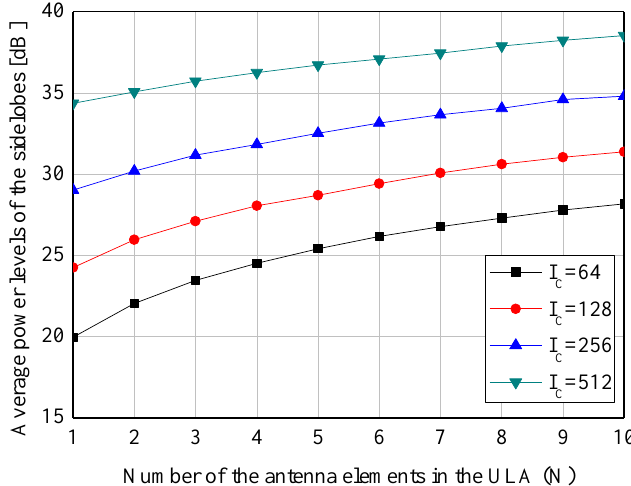
Figure 3. Simulation results of the system model with various N and I C - Average power levels of the (cid:16) (cid:17) P ϕ j sidelobes, ∑ 4 /3, over the undesired directions of ϕ 2 = π /3, ϕ 3 = 2 π /3, and ϕ 4 = π j = 2